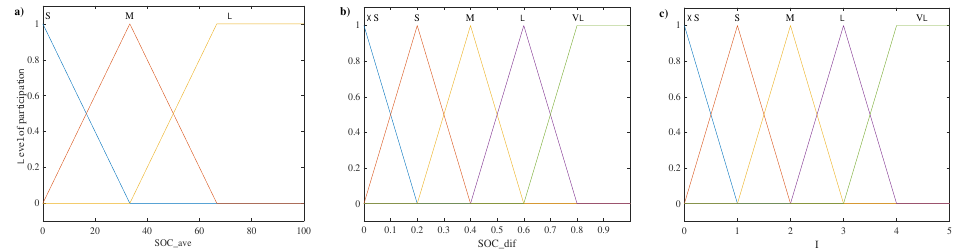
Figure 8. ( a ) Affiliation function of SOC ave ; ( b ) Affiliation function of SOC dif ; ( c ) Affiliation function of I